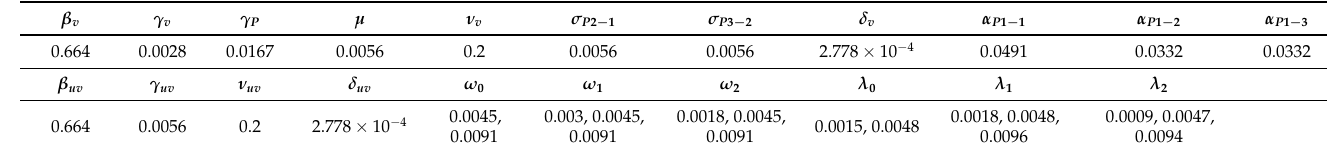
Table A5. Rate parameters used for Figures 11–13.